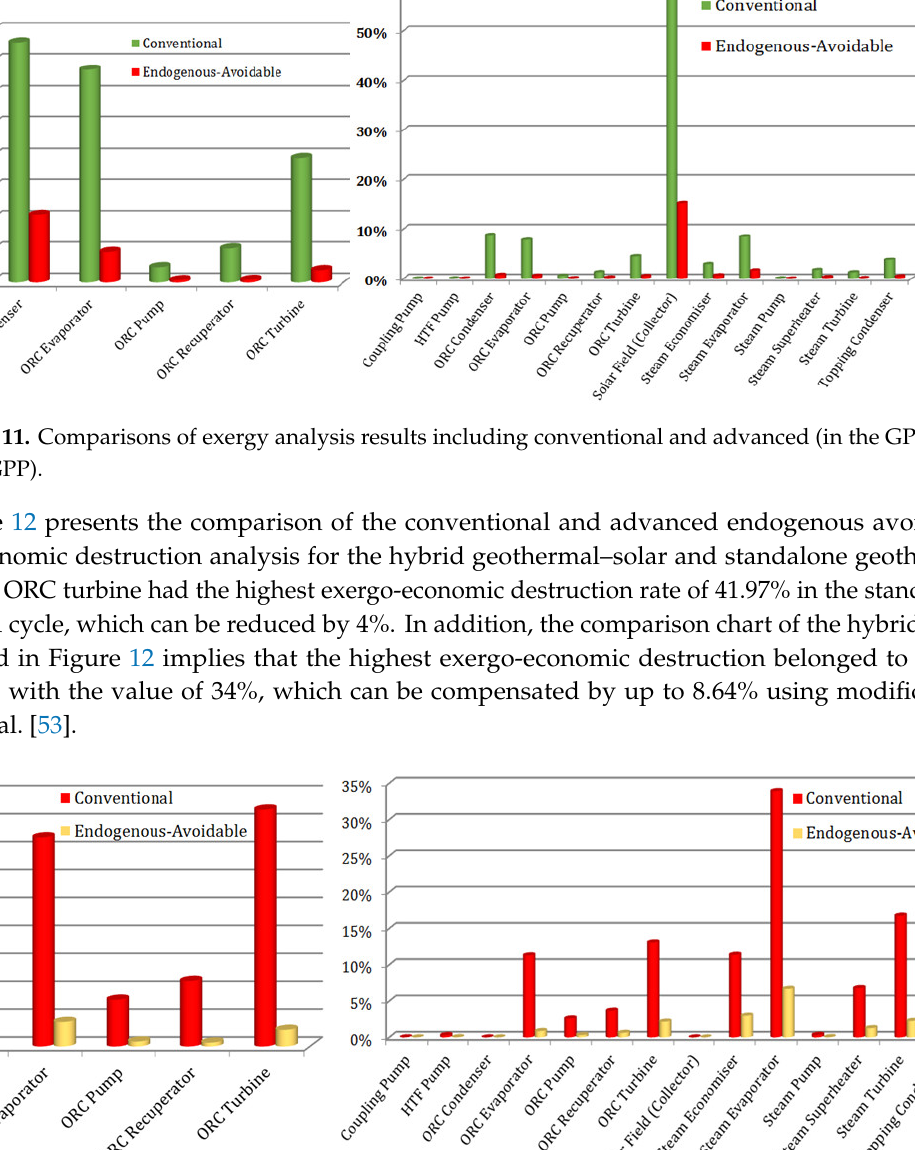
Figure 13. Comparisons of exergo-environmental analysis results including conventional and advanced (in the GPP and SGPP). After the conventional exergy analysis, by determining the efficiency in the exergy, exergo- economic and exergo-environmental analyses, the prioritization of equipment for optimization could be determined i.e., any equipment with a lower efficiency had priority optimization (Table 19).